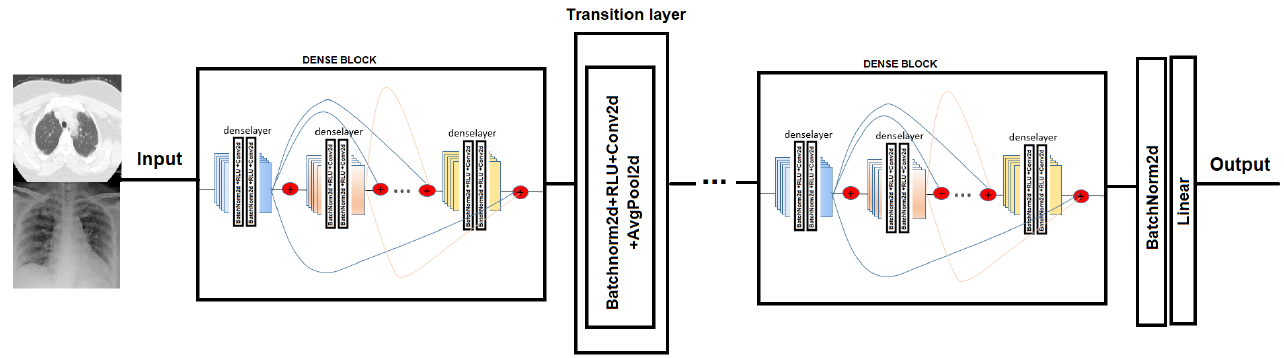
Figure 4. Densenet model network. In the Dense-block each deselayer takes all the preceding feature-maps as an input